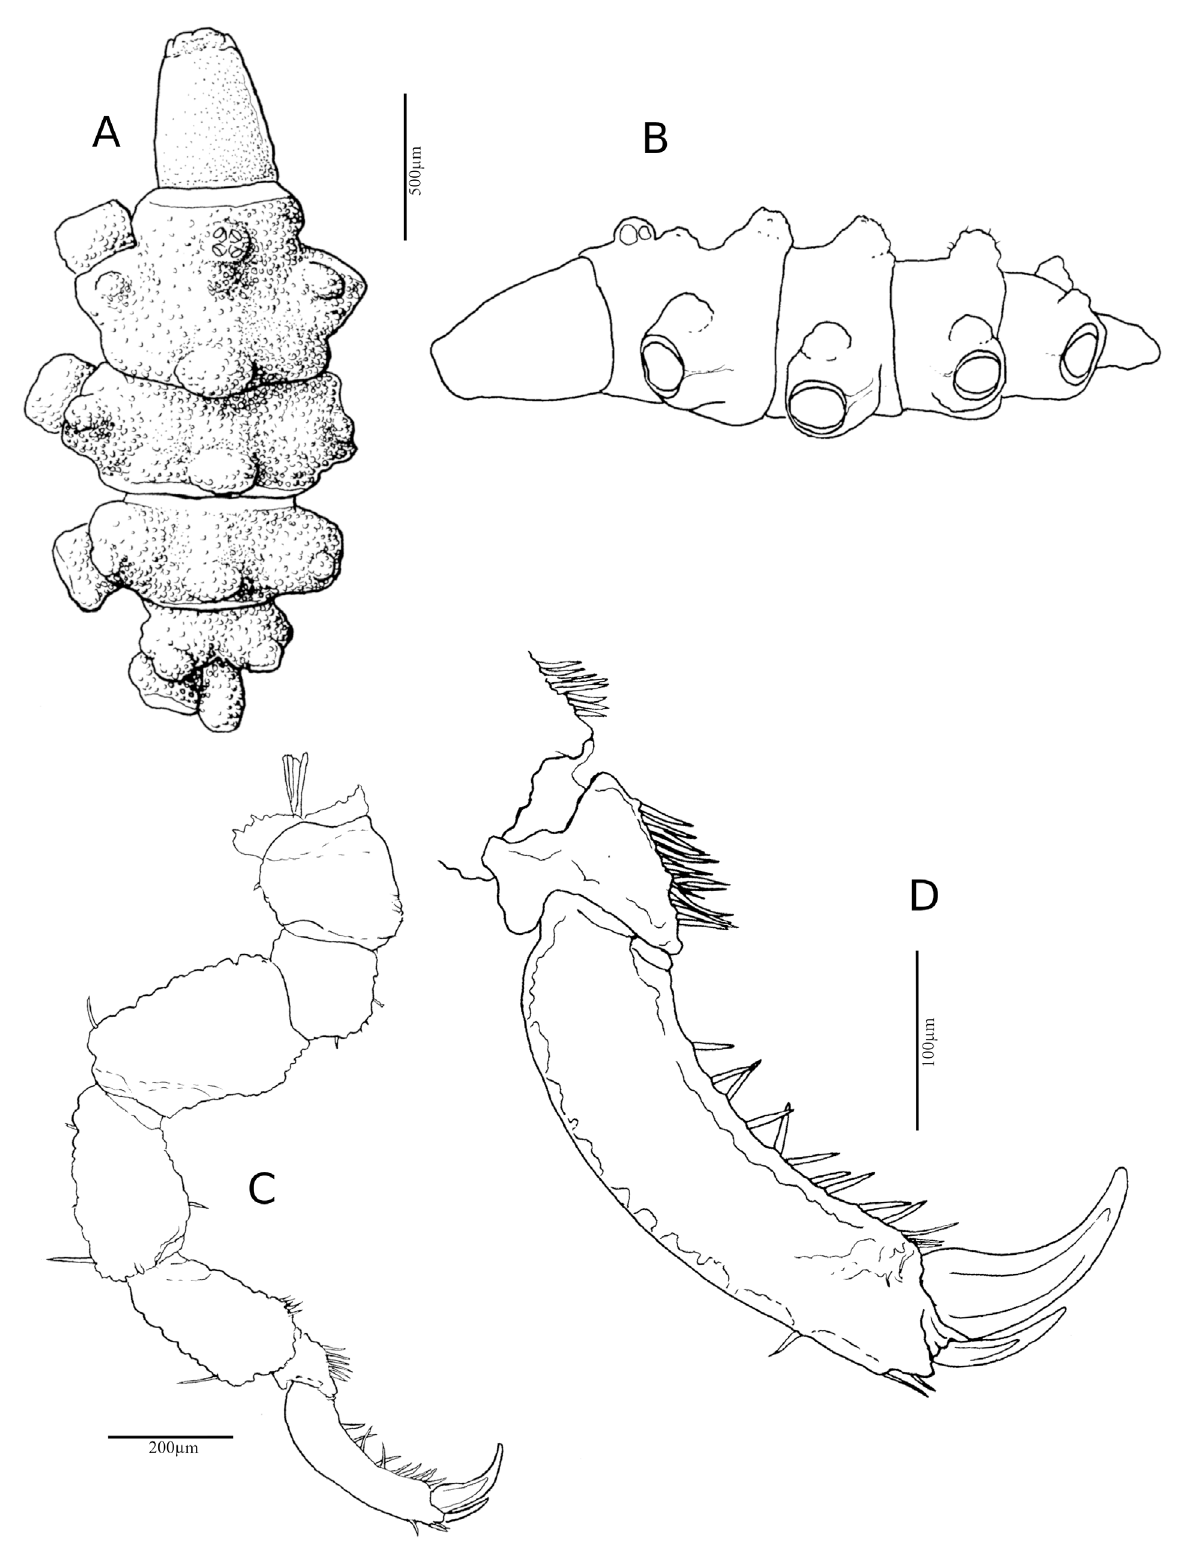
Fig. 30. Pycnogonum cf. pusillum Dohrn, 1881, ♀, MNHN-IU-2016-815. A . Body, dorsal view. B . Body, lateral view (same scale as A). C . Third leg. D . Tarsus and propodus of third